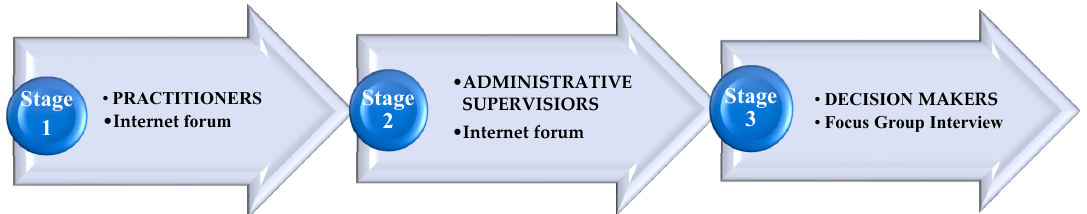
Figure 1. Project scheme—research project